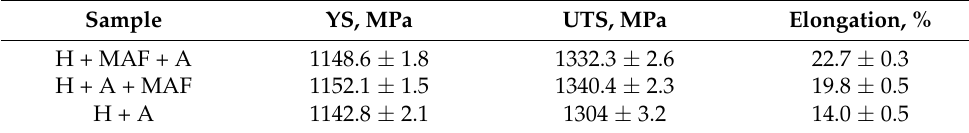
Figure 5. Stress–strain curves of the fully heat-treated sample H + A (without the MAF process), sample H + A + MAF (with the MAF process after the full heat treatment), and sample H + MAF + A (with the MAF process between the homogenization and aging processes). Table 7. Tensile properties of samples H + A, H + A + MAF, and H + MAF + A.